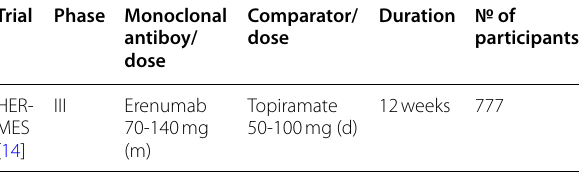
(m) indicates monthly, (d) indicates daily